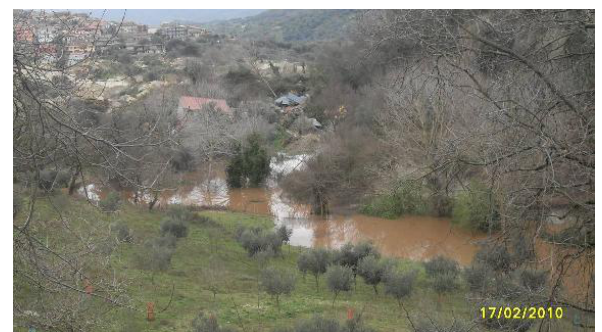
Figure 4.Water pool on the bottom of the Scotrapiti valley